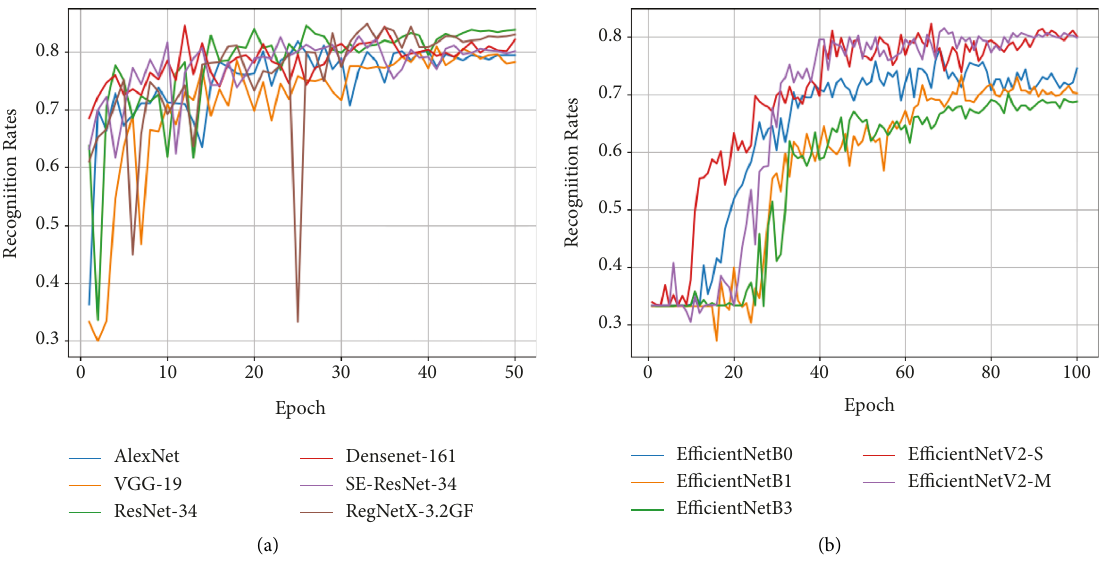
Figure 12: (a) Recognition rates of each best CNN method during training. (b) Recognition rates of EfficientNetV1 and V2